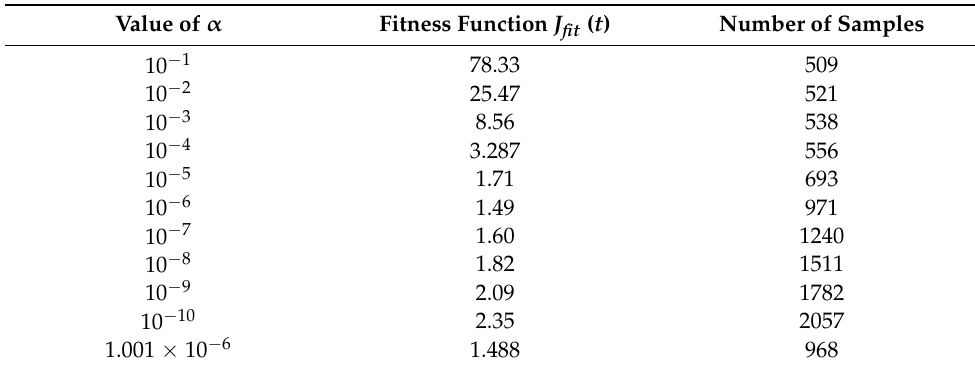
Table 4. Fitness Function and Number of Samples for Single-Link